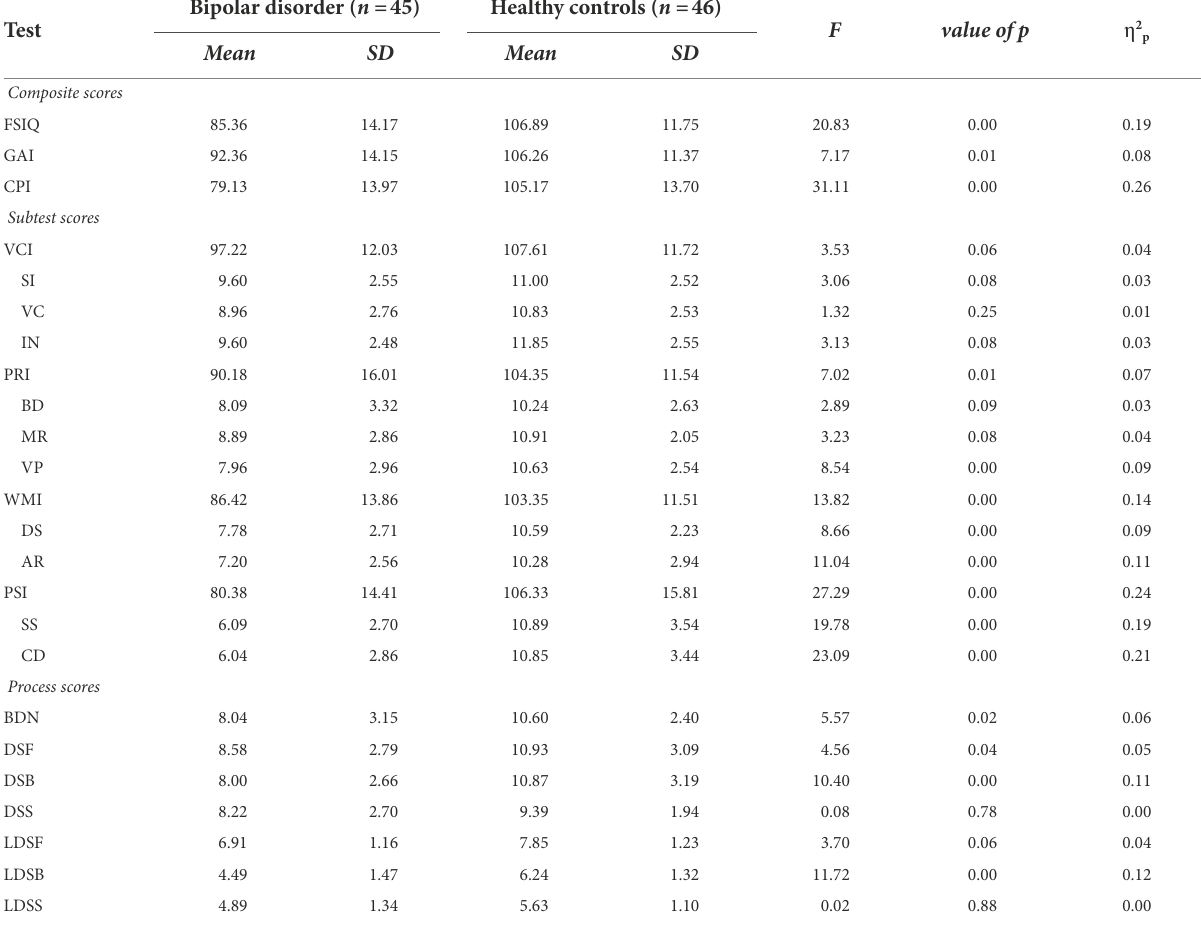
TABLE 3 Group differences in the WAIS-IV index, subtest, and process